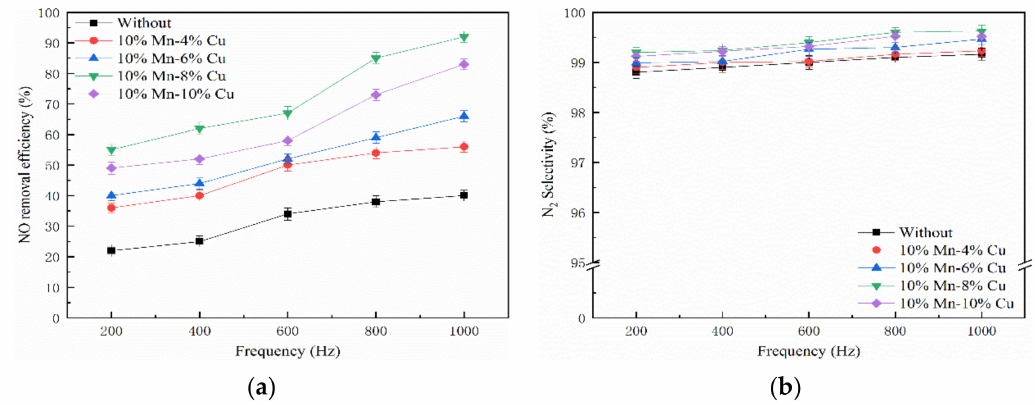
Figure 5. E ff ect of frequency on NO removal e ffi ciency. ( a ) NO removal e ffi ciency and ( b ) N 2